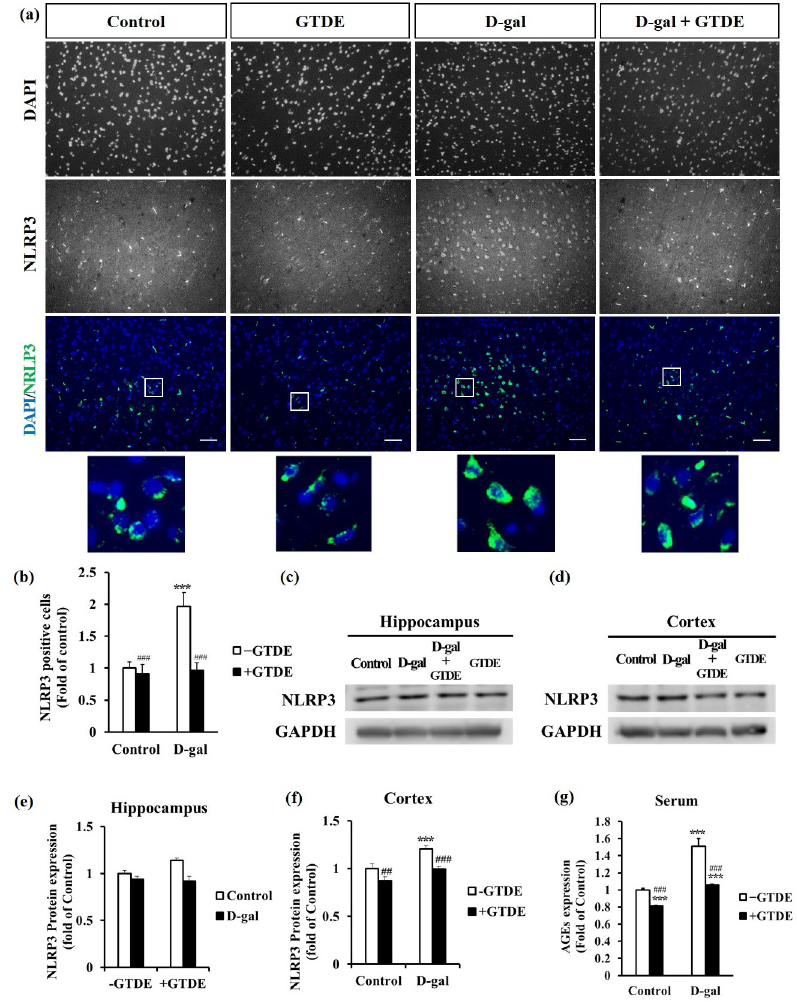
Fig 4. GTDE decreased the expression of the NLRP3 inflammasome and AGEs in the cerebral cortex. (a) Immunohistochemical stains for NLRP3 inflammasome expression in the cerebral cortex (scale bar = 50 μ m). The squared area in the DAPI/NRLP3 merged image was enlarged and showed underneath the original image. (b) Quantified results of immunohistochemical staining, which indicates the NLRP3 positive cells. n (images) value = 9 (control); 10 (GTDE); 11 (D-gal); 11 (D-gal+aging). (c)–(f) Changes in NLRP3 expression in the hippocampus and cerebral cortex. (c)–(d) Representative Western blots for the hippocampus and cerebral cortex. (e)–(f) Corresponding quantified results. n = 6. (g) Results of the analysis of the concentration of the AGEs in serum (n = 7). Intergroup differences were compared using one-way ANOVA followed by the Tukey’s multiple comparisons test. Statistically significant differences based on comparisons with the control group are denoted by � P < 0.05, �� P < 0.01, ��� P < 0.001; statistically significant differences based on comparisons with the D-gal group are denoted by # P < 0.05, ## P < 0.01, ### P <